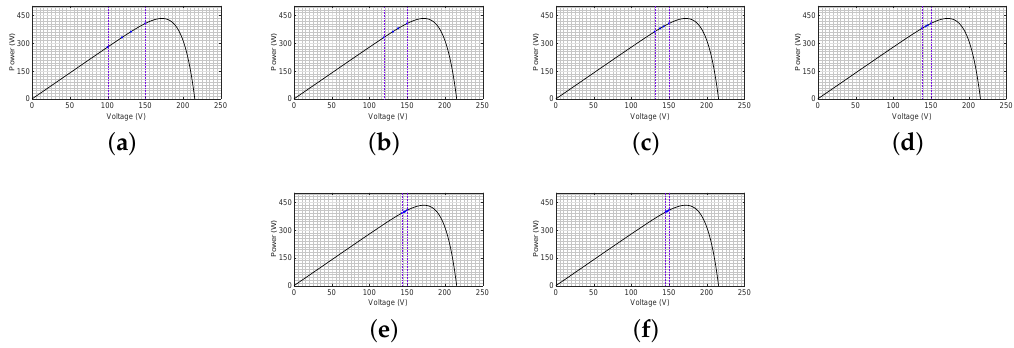
Figure 15. GSS not bracketing MPP. ( a ) 1st; ( b ) 2nd; ( c ) 3rd; ( d ) 4th; ( e ) 5th; and ( f ) 6th